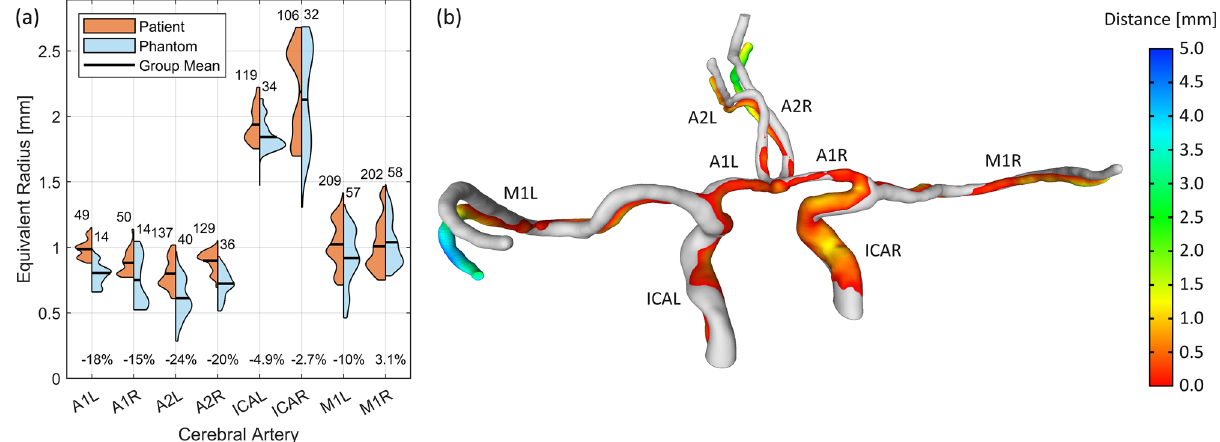
Figure 2. We compare the arterial network before and after recreating it as a phantom model in PDMS. In panel ( a ), we show the distributions of best fit circle radius along the arterial network of both the patient (CTA) model and the MRI scan of the phantom model. It is calculated at arbitrary positions (uniformly spaced) along each channel segment and the sample size is indicated above each group. The change in mean radius is shown in percentages for each segment and this is calculated relative to the CTA model. In panel ( b ), the patient model (gray) is superposed with the phantom model (colored) and a measurement of the channels deviation (Hausdorff distances) is shown by the color scale. A anterior cerebral artery, M middle cerebral artery, ICA internal carotid artery ( L left, R